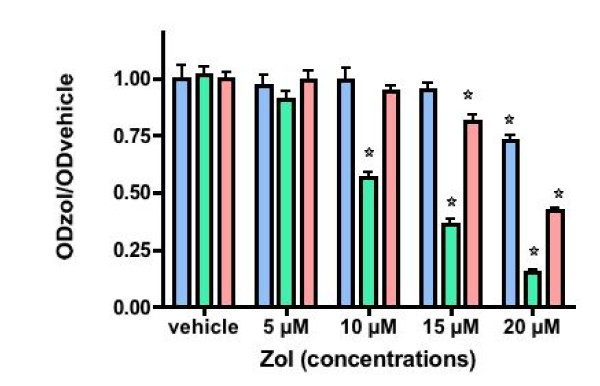
Effect of zoledronate on proliferation of PC-3, PNT1-A and LNCaP. At D0, the cells were seeded into 96-well plates to obtain 80% confluence at D5 in control wells. At D1 and D3, cells were treated by vehicle or increasing doses of zoledronate (ZOL: 5, 10, 15, 20 μM). At D5, the cells were fixed with TCA and stained with 0.4% sulforhodamine. Staining intensity was quantified at 540 nm. Results are expressed as the ratio ODtreatedcells/ODuntreated of three independent assays each performed six times. Error bars indicate inter-assay mean ± 1 SD. * indicates a significant difference versus non-treated cells (p < 0.01).  PC3  PNT1A  LNCaP